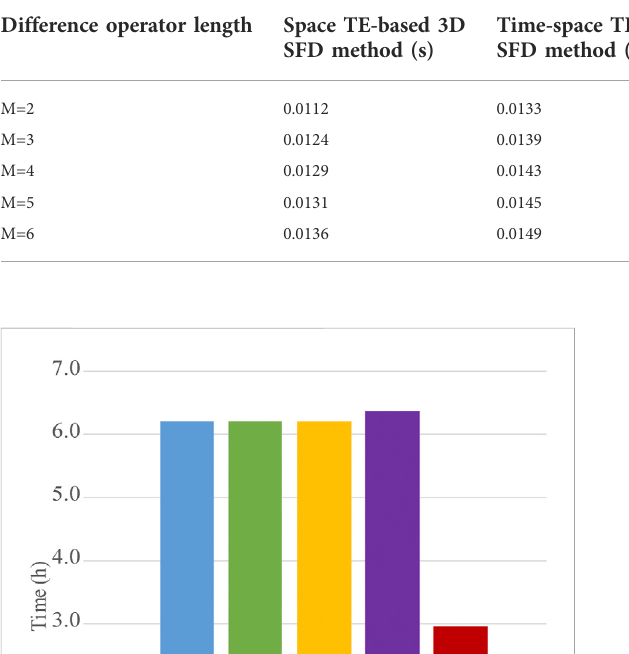
TABLE 1 Computational cost of four 3D SFD coef fi cients with different difference operator lengths.